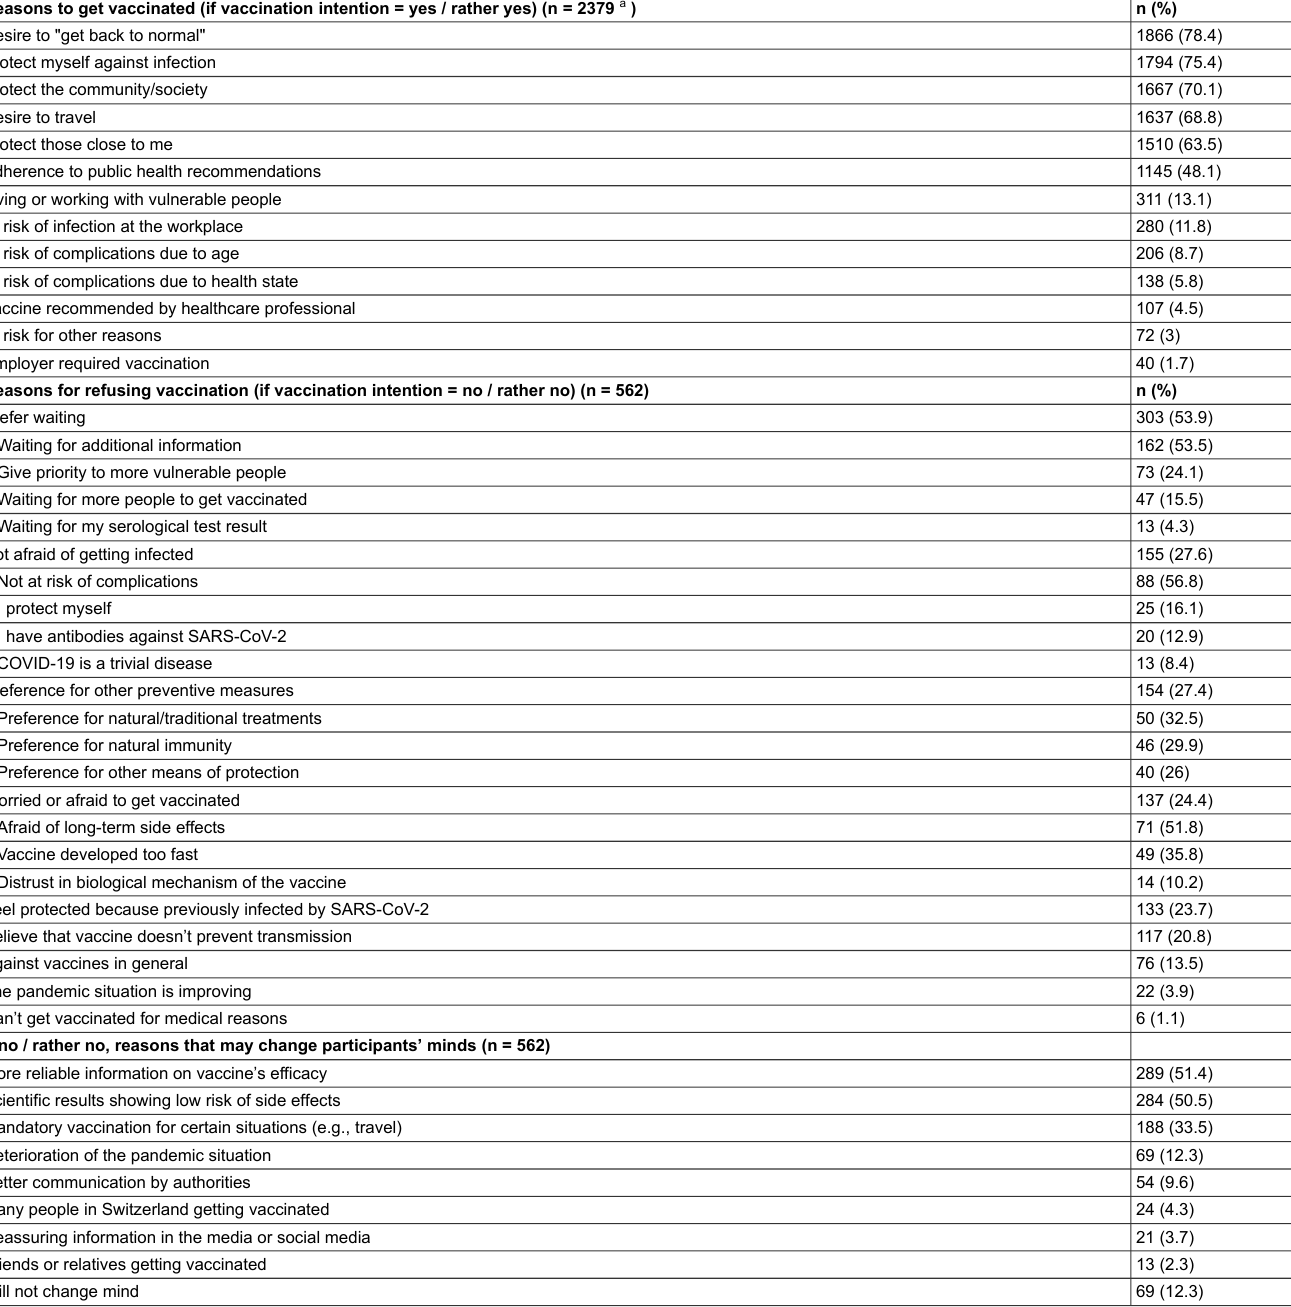
Table 1: Reasons to get vaccinated, reasons for accepting or refusing vaccination, and reasons that might change participants’ minds. Reasons to get vaccinated (if vaccination intention = yes / rather yes) (n = 2379 a